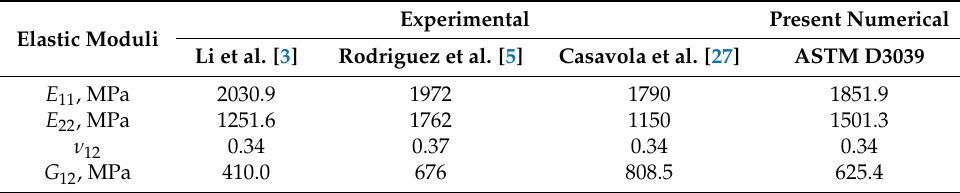
Table 2. Layer properties of the part processed by FDM for regular